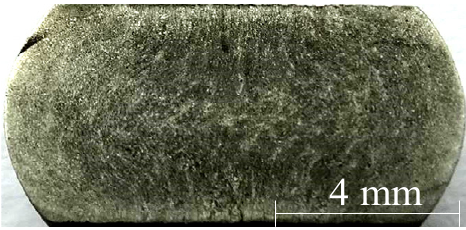
Figure 3. Macrostructure of the upset sample.